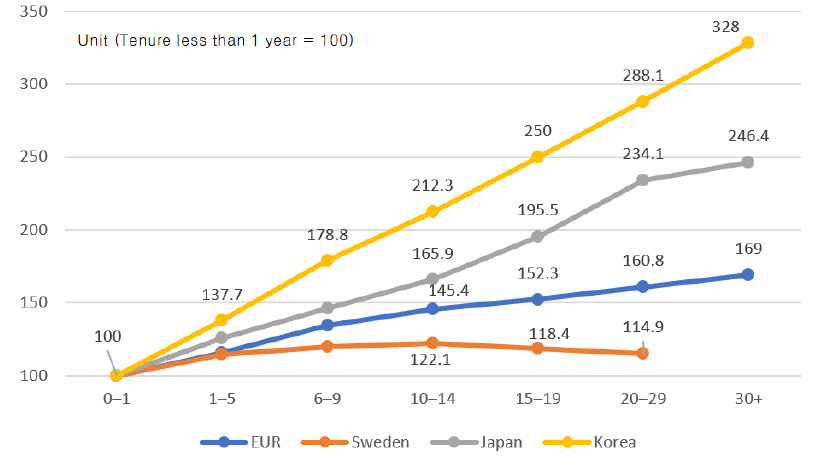
Figure 9. Relative wage dispersion by tenure (2010). Source: Jeong. J.H. [38].